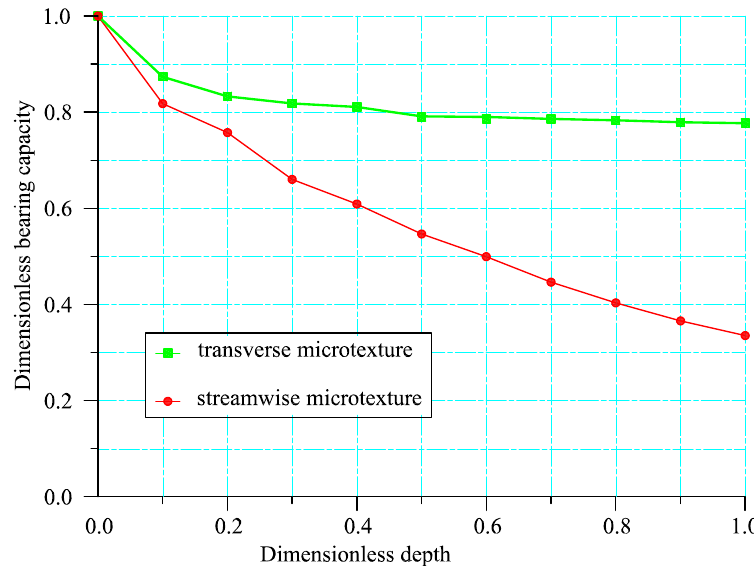
Figure 8. Effects of dimensionless depth of microtexture on carrying capacity.